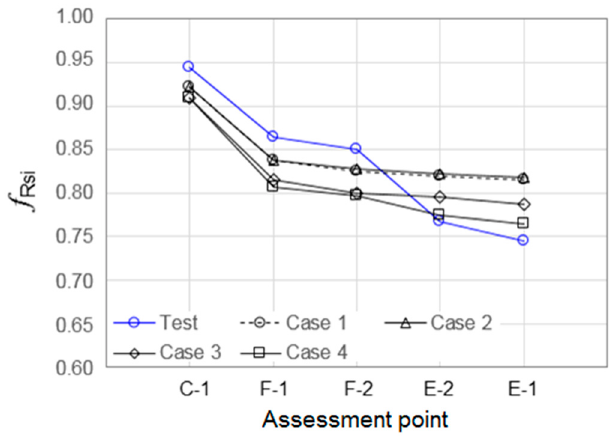
Figure 9. Measured and calculated temperature factors ( f Rsi ) at each assessment point.